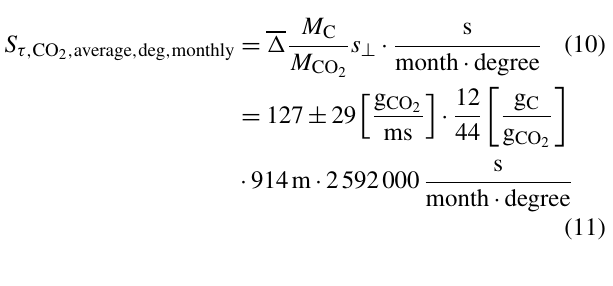
For comparison with gridded emission inventories in Sect. 7, the CO 2 emissions are scaled to average monthly carbon emissions per wind direction (in 1 ◦